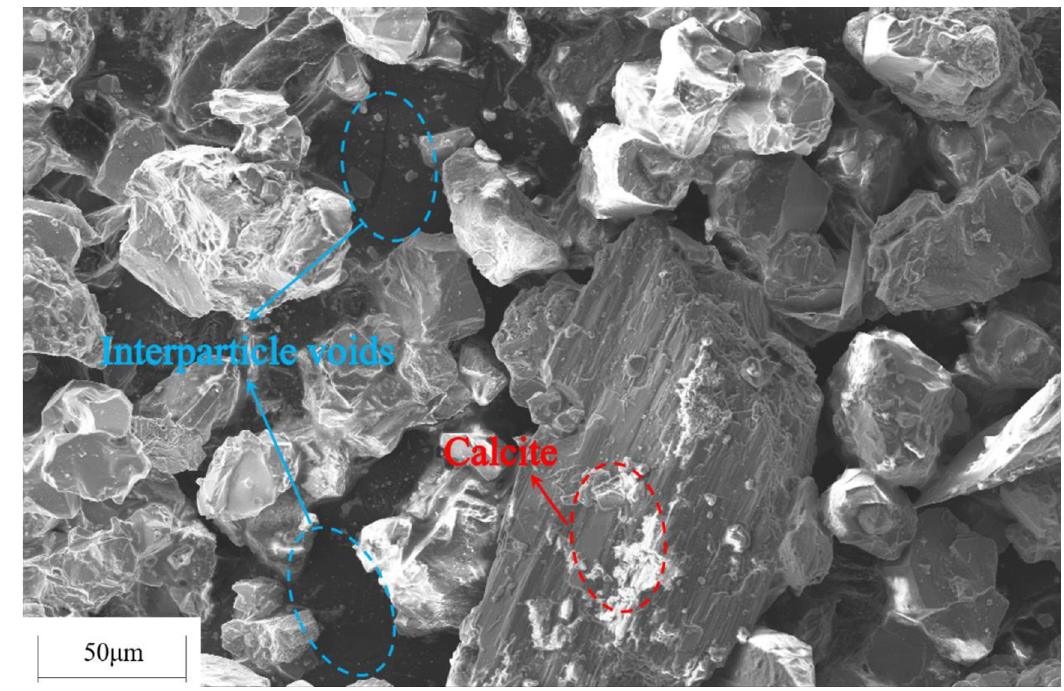
Fig 12. SEM image of tailings specimen for cementing solution concentration of 0.25 mol/L.